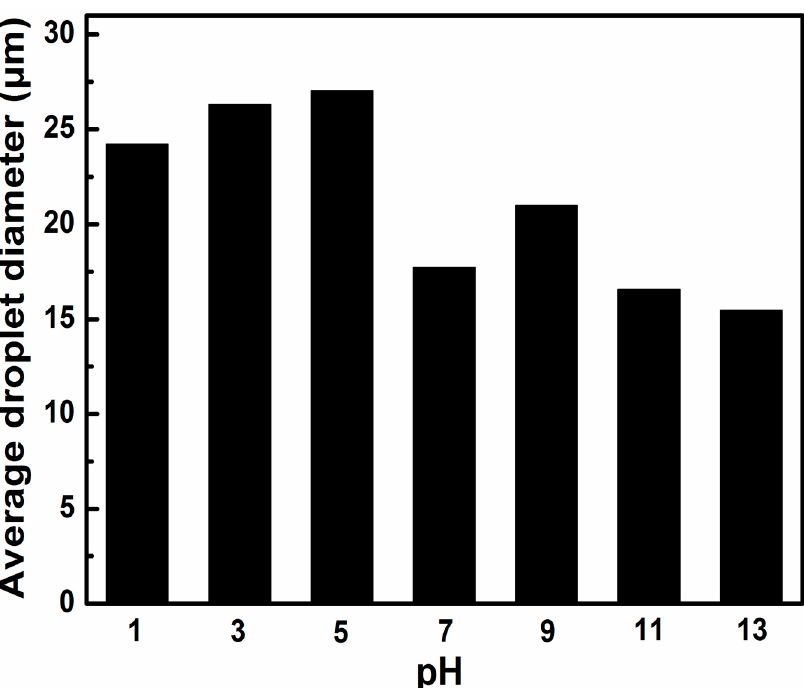
Figure 6. Average droplet diameter of Pickering emulsions stabilized by AmGO18-1 as a function of pH values. AmGO18-1 concentration: 1 mg/mL. Toluene/water ratio: 1:1. Scale bar: 100 μ m.